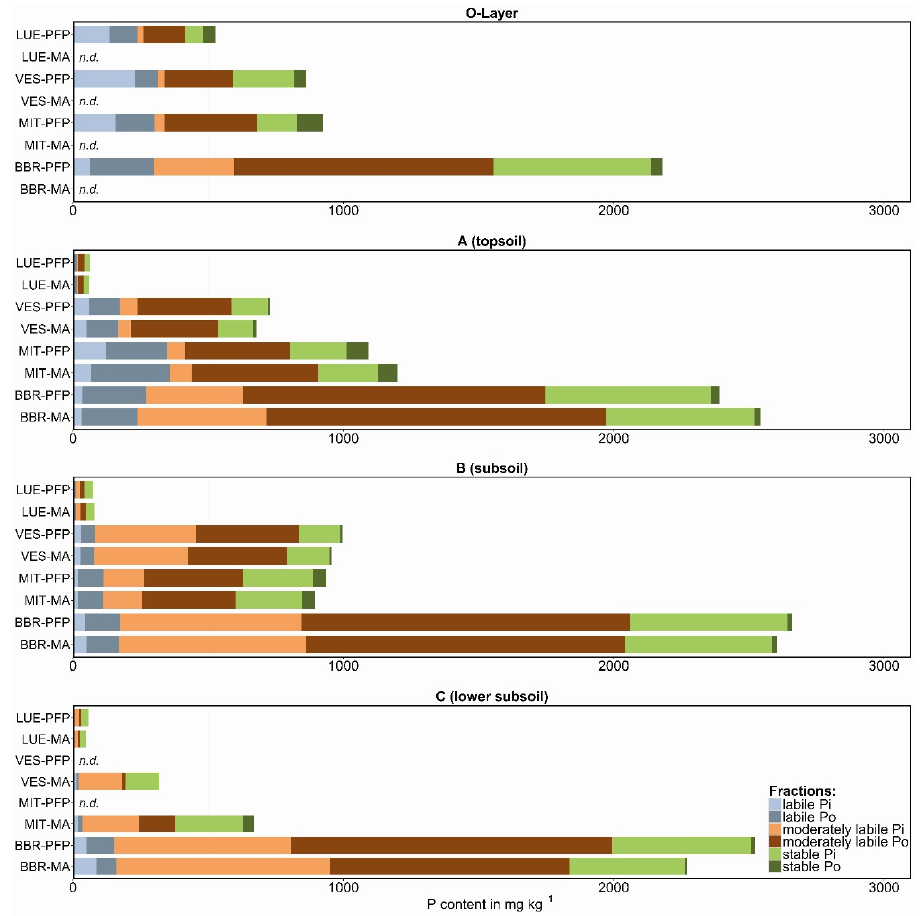
Figure 2. Phosphorus fractions summarized as labile (resin ‐ P i + NaHCO 3 ‐ P i,o ), moderately labile (NaOH ‐ P i,o + HCl dil ‐ P i ), and stable P (HCl conc ‐ P i,o + residual ‐ P) for PFP (preferential flow pathways)